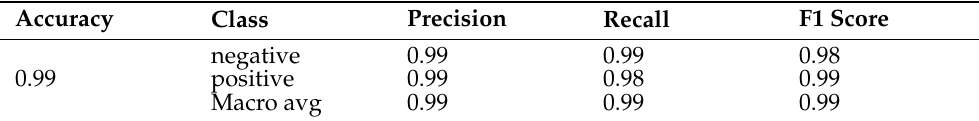
Table 14. Experimental results of LR-LSTM with TextBlob sentiments.